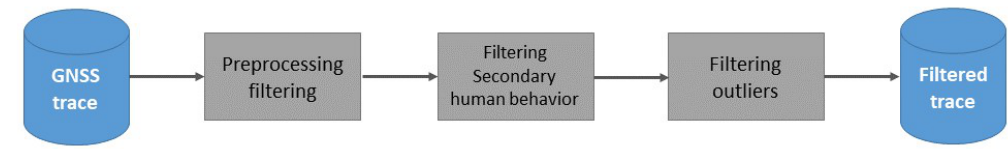
Figure 2. The proposed approach for filtering a crowdsourced GNSS